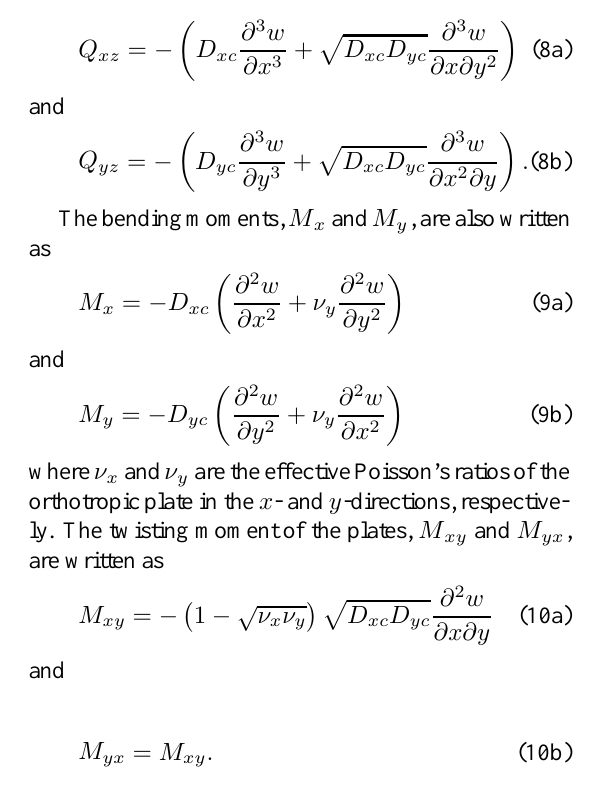
Fig. 6. The approximate intensity field in the orthotropic plate when f = 500 Hz and η = 0 . 02